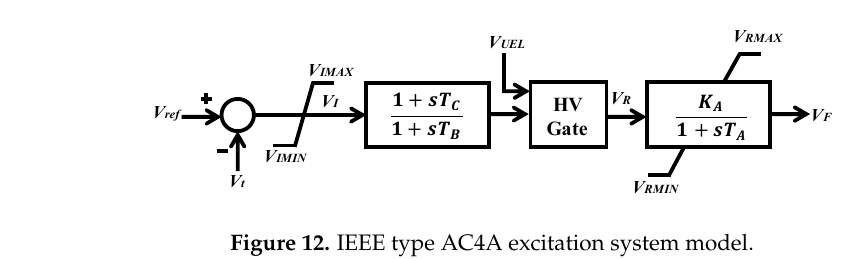
Figure 11. Power system model.